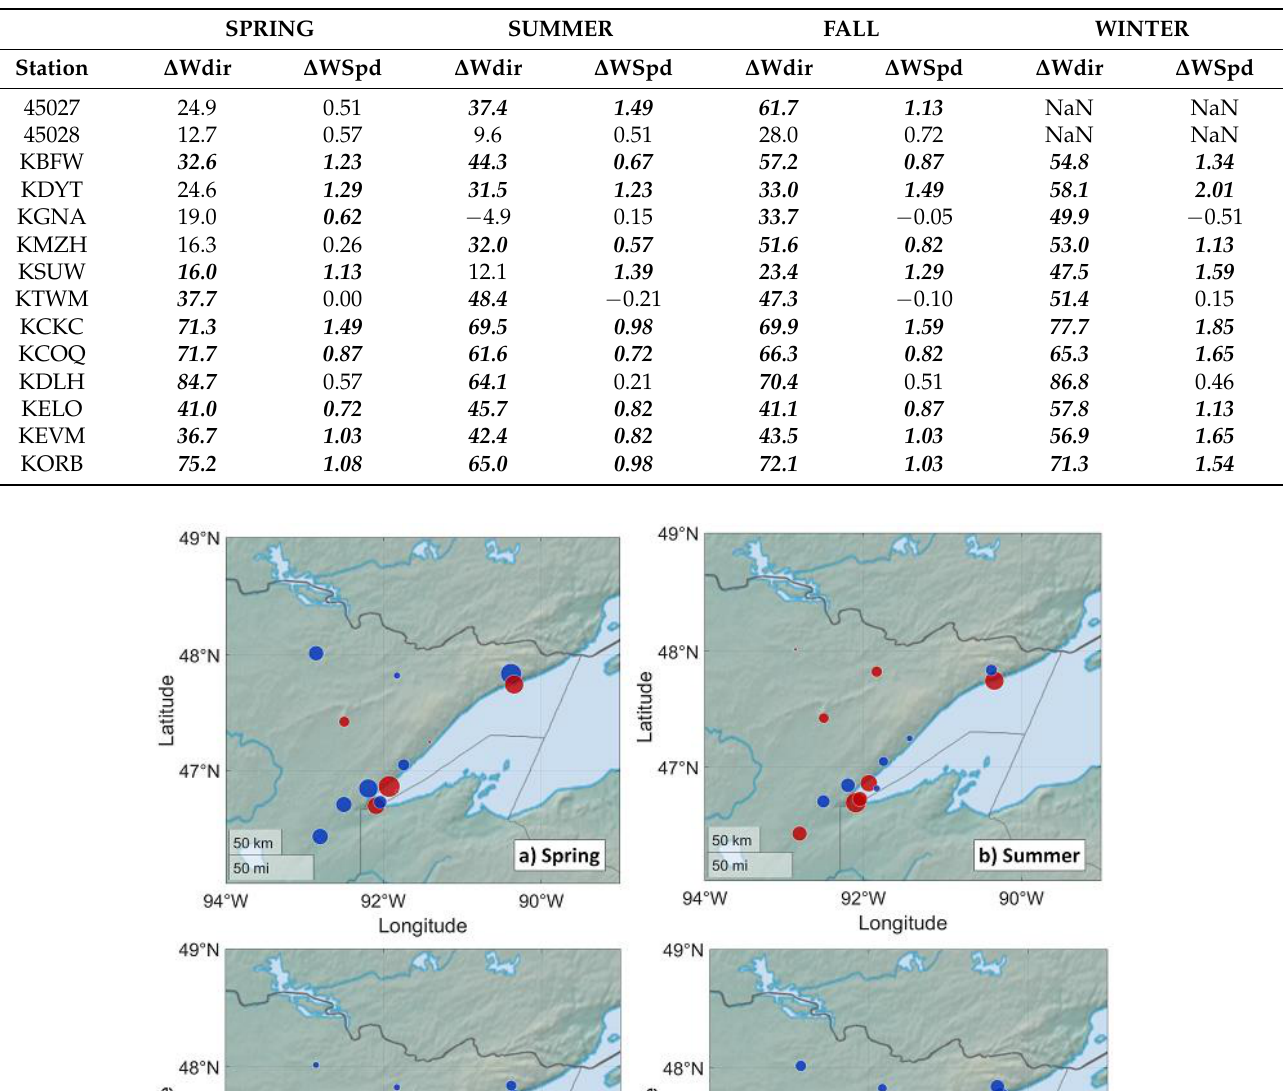
Table 5. As in Table 4 except for average wind direction (Wdir, degrees) and speed (WSpd, m s − 1 ) changes in each season. Values in bold/italics are significant at the 1% level according to a Wilcoxon signed-rank test.